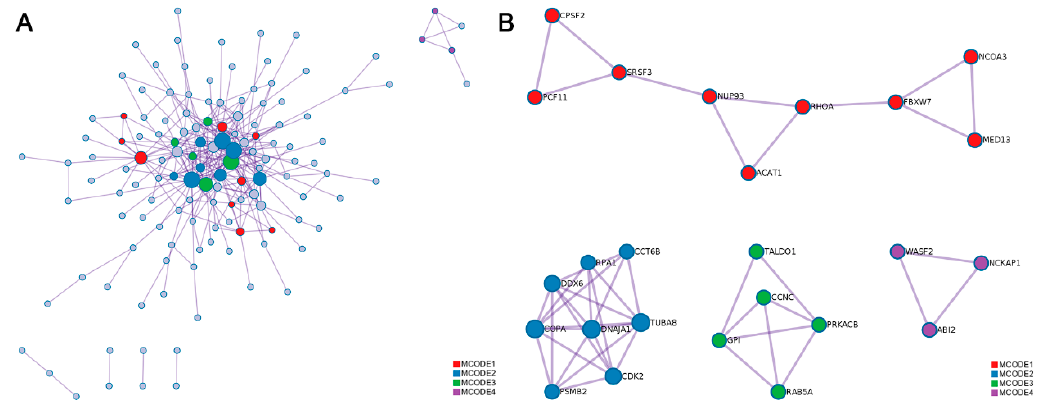
Figure 7. Protein–protein interaction (PPI) network of genes with differential RNA editing sites. ( A ) PPI network of all of the coding proteins. ( B ) The independent PPI networks of molecular complex detection (MCODE) components. The proteins in same MCODE represent densely connection. Different MCODE networks were shown in different color.